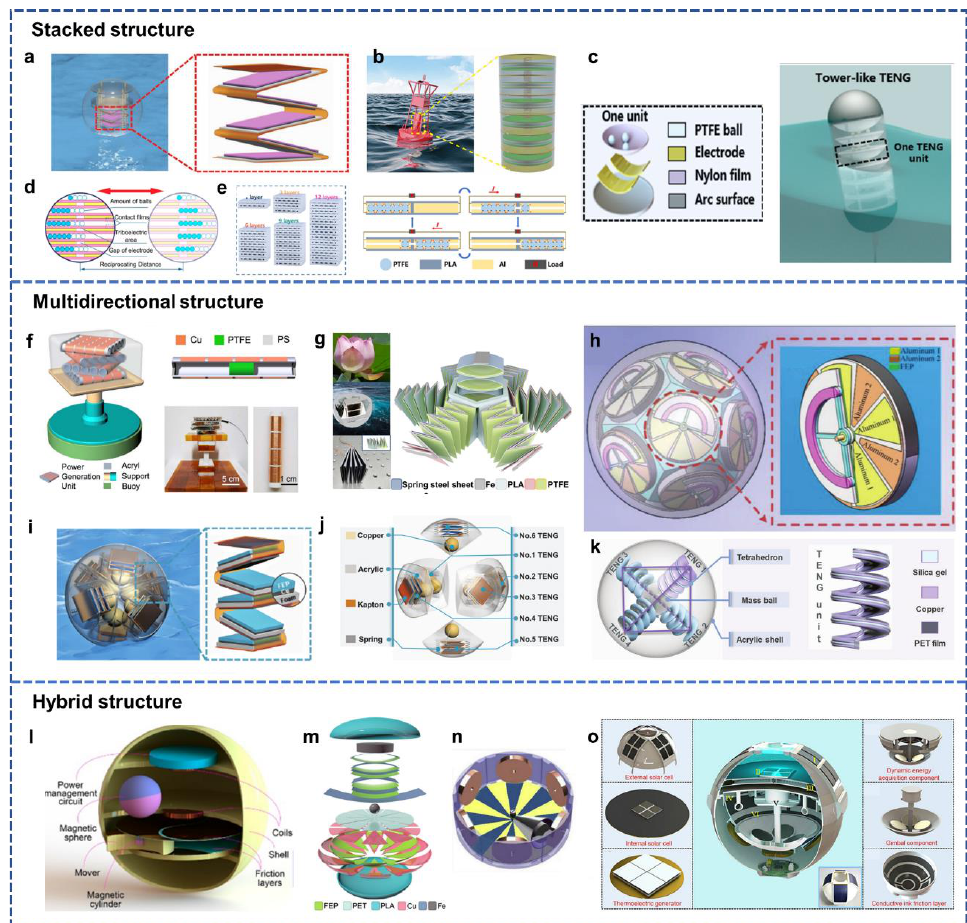
Figure 1. ( a ) Schematic diagram of the folded structure with five TENG units inside the spherical device floating on water. Reprinted with permission from ref. [37], Copyright 2018, Wiley. ( b ) Struc- ture of the stacked TENG in the buoy. Reprinted with permission from ref. [38], Copyright 2019, Elsevier. ( c ) Schematic diagram of the tower-like device containing several TENG units. Reprinted with permission from ref. [39], Copyright 2019, American Chemical Society. ( d ) Spherical device with multiple TENG units stacked inside it. Reprinted with permission from ref. [40], Copyright 2021, American Chemical Society. ( e ) Schematic working cycle of a single TENG unit, and installing the